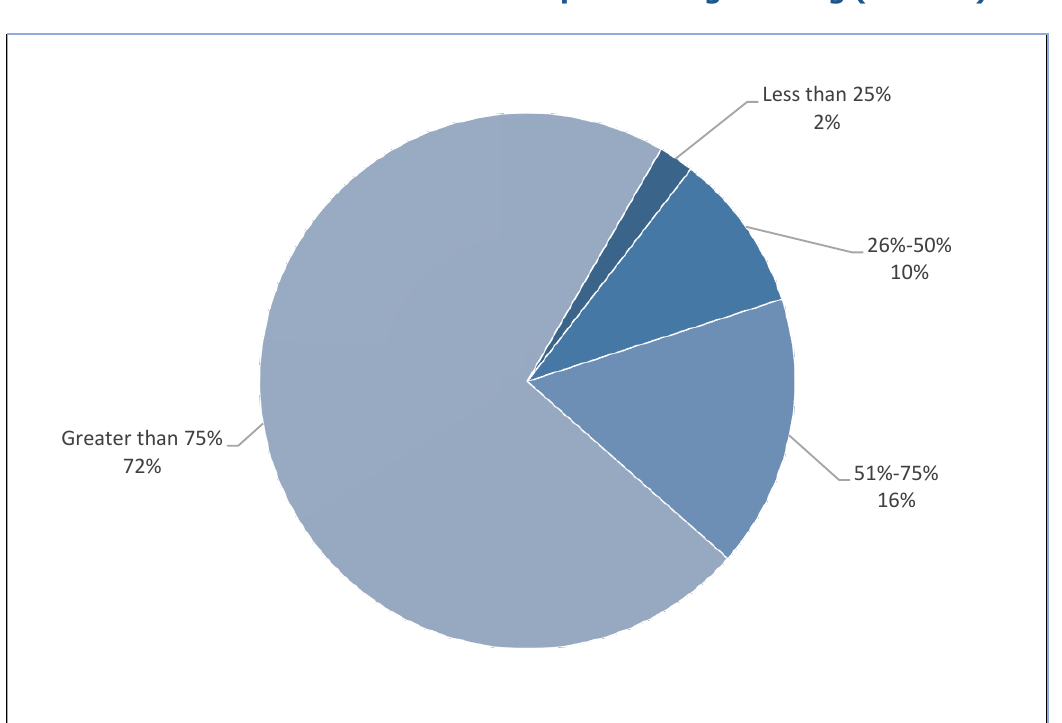
Figure 1. Effort focused on 4-H Youth Development Programming (n =